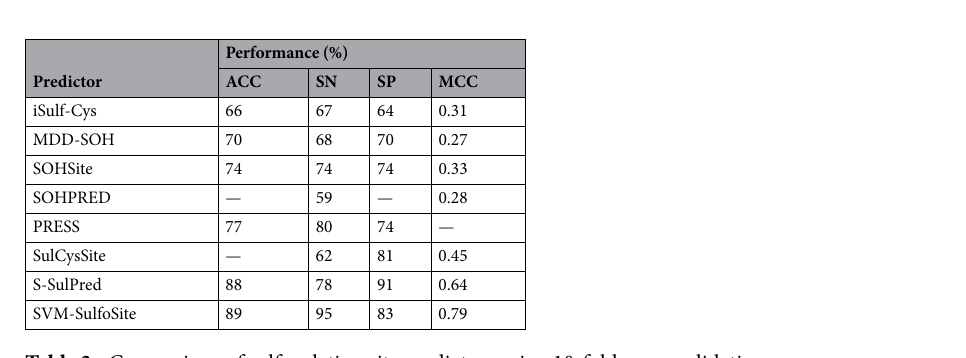
Table 3. Comparison of sulfenylation site predictors using 10-fold cross-validation.